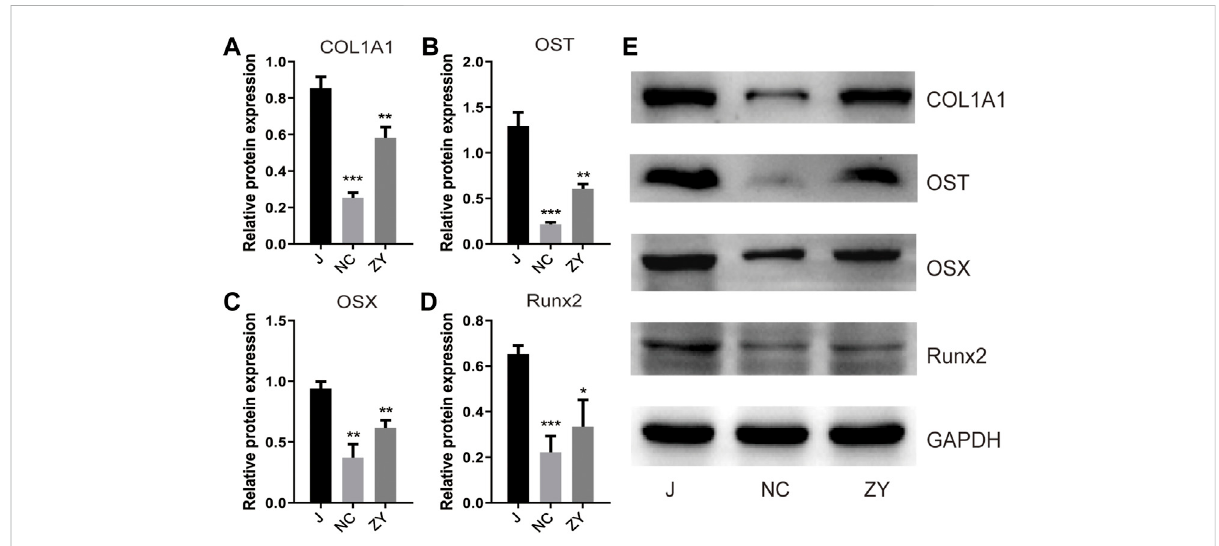
FIGURE 1 JG improved the expression of bonemetabolic biomarkers. Expression of typeI collagen (Col1a1). (A) , osteocalcin (OST). (B) , Osterix (OSX). (C) , and Runx2. (D) in each group by western blot analysis. (E) . The data are presented as the mean ± standard deviation, with n = 3 samples for